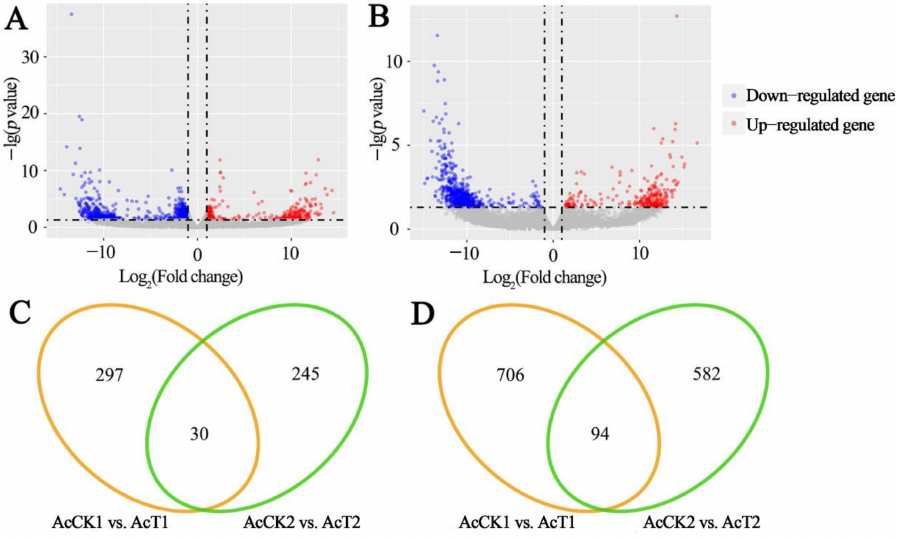
Figure 2. DEGs in A. c. cerana workers’ midgut response to N. ceranae infection. ( A , B ) Valcano plots of DEGs within AcCK1 vs. AcT1 and AcCK2 vs. AcT2 comparison groups. ( C , D ) Venn analysis of up-regulated and down-regulated genes within two comparison